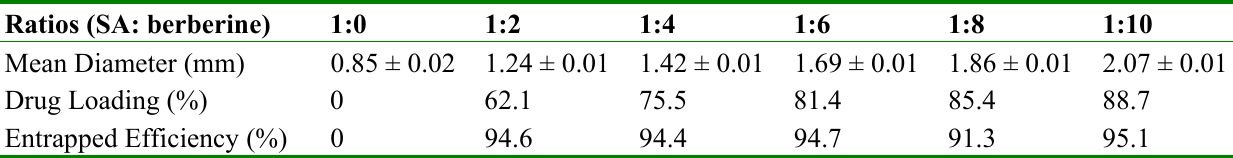
Table 1. The characterization of beads in different ratios SA to berberine (n >